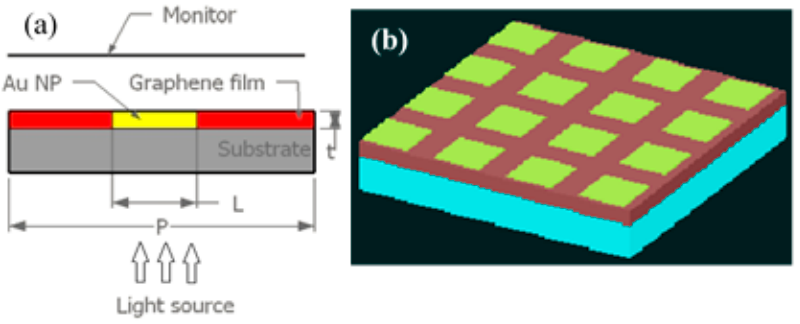
Figure 1. ( a ) 2D schematic diagram of proposed sensor used in this study. L is the side length of cubic and prism NPs, and the diameter of the cylindrical NPs, t is the NPs thickness, and P is the separation distance between two consecutive NPs; and ( b ) the perspective view of the Au-graphene hybrid sensor.